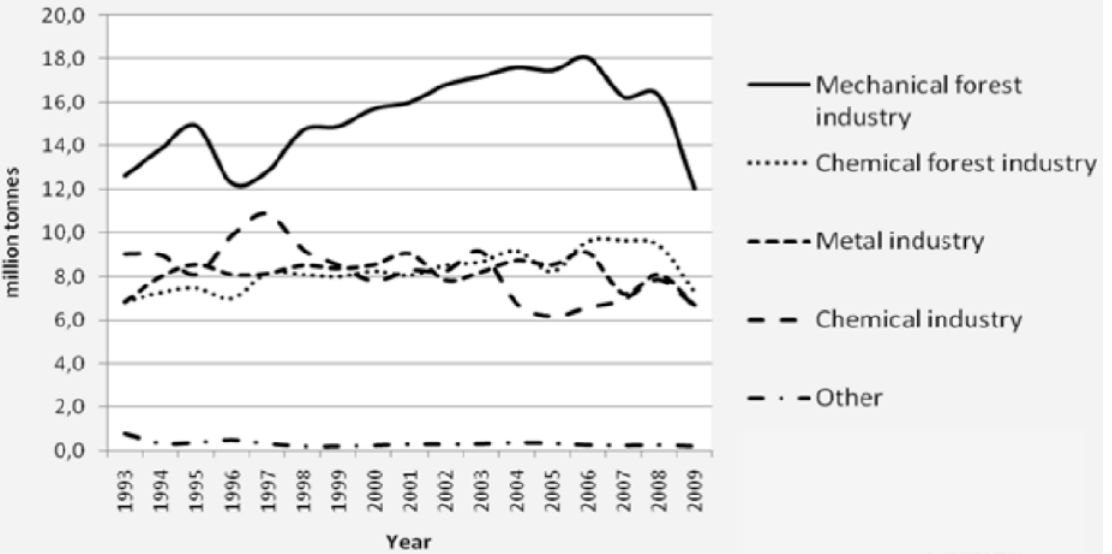
Figure 5. Finnish rail transport volume development by product groups 1993–2009 (Source: Lahelma,